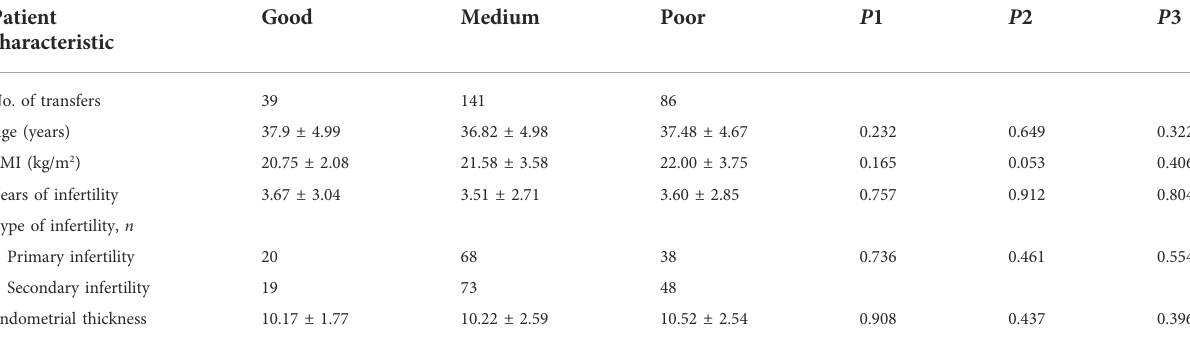
TABLE 2 Patient characteristics of embryos with different morphological grades between 2007 and 2020. Patient Good Medium Poor P 1 P 2 P characteristic